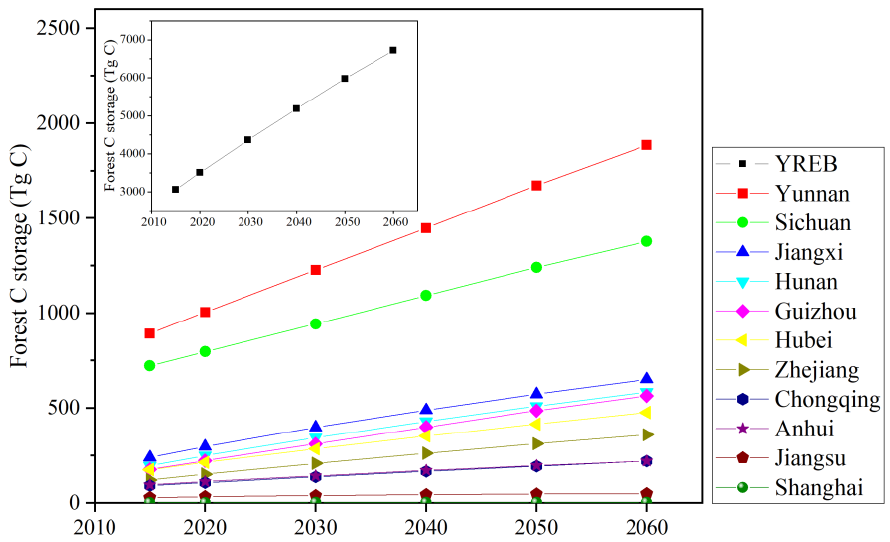
Figure 3. Predicted variations in forest biomass C storage from 2015 to 2060 in the YREB.